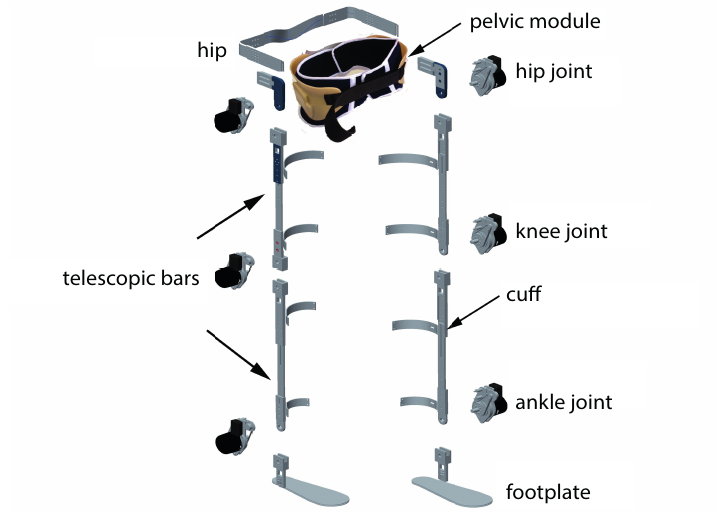
Figure 2. Exploded view of the H1 exoskeleton mechanical structure.